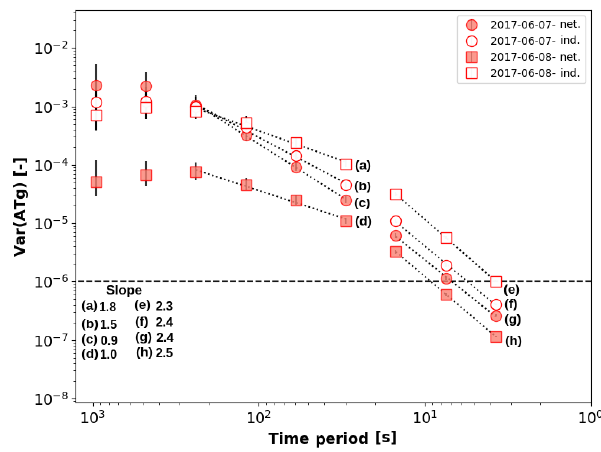
Figure 14. Wavelet-based power spectral density (WSD) of the station-averaged ATg (filled circles) and averaged WSD from the individual stations (empty circles) for 3h periods (15:00–18:00Z) with broken cloud (8 June 2017), multilayer (13 June 2017), and overcast (6 June 2017) conditions. The dashed horizontal line de- notes the measurement uncertainty of the pyranometer.